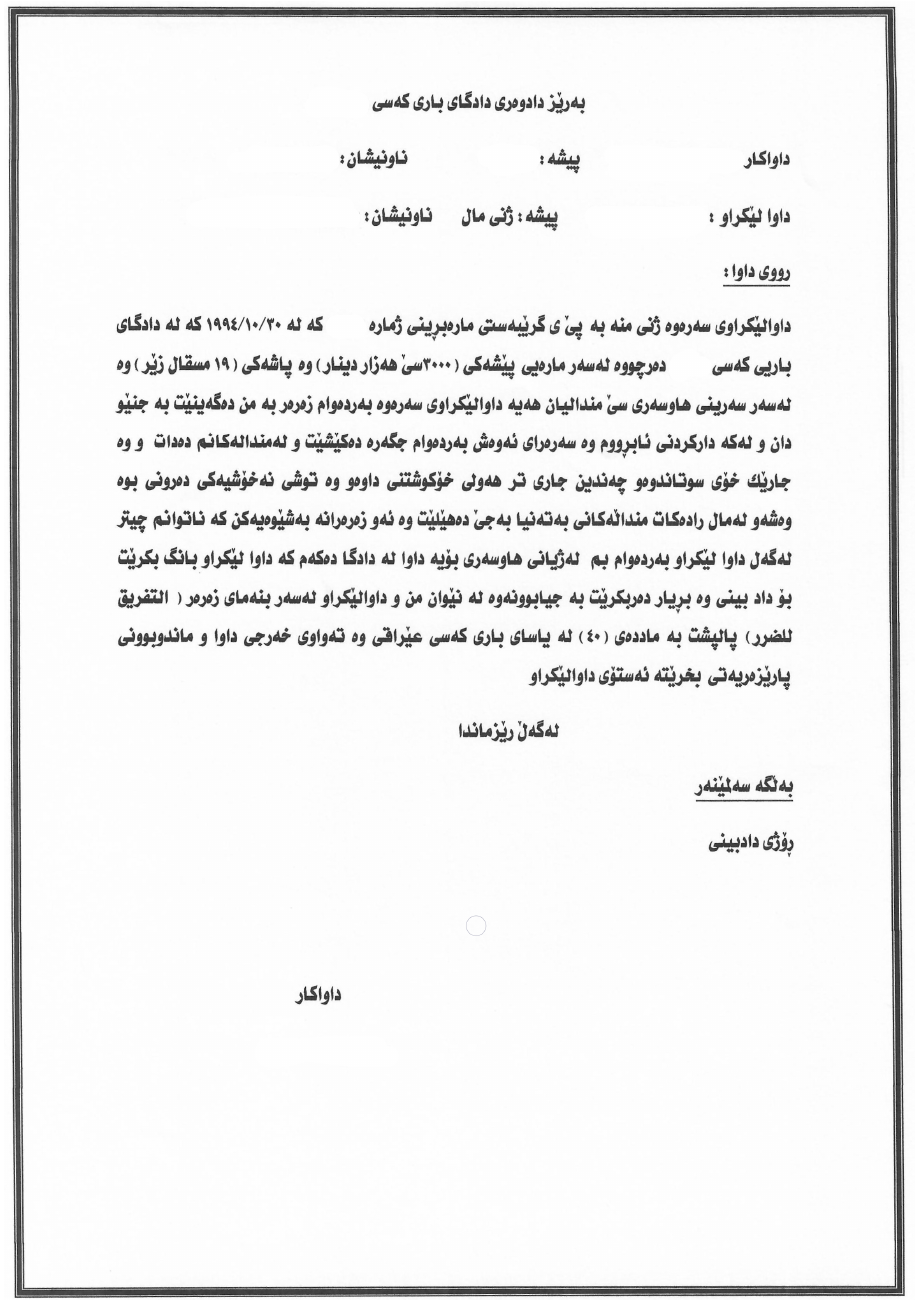
Figure 10. Court document image for evaluation by final model